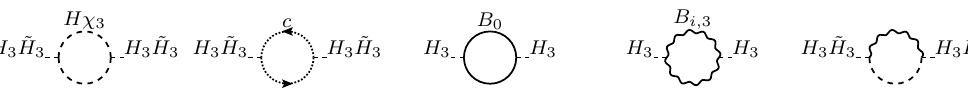
Figure 3 . Diagrams contributing to the field renormalization factor Z at one-loop. Where dashed lines are either Higgs ( H 3 ) or Goldstone ( χ 3 ), wiggly lines are spatial gauge bosons ( B i, 3 ), black lines are adjoint scalar ( B 0 ), and dotted directed lines are ghosts ( ¯ c, c ). in figure